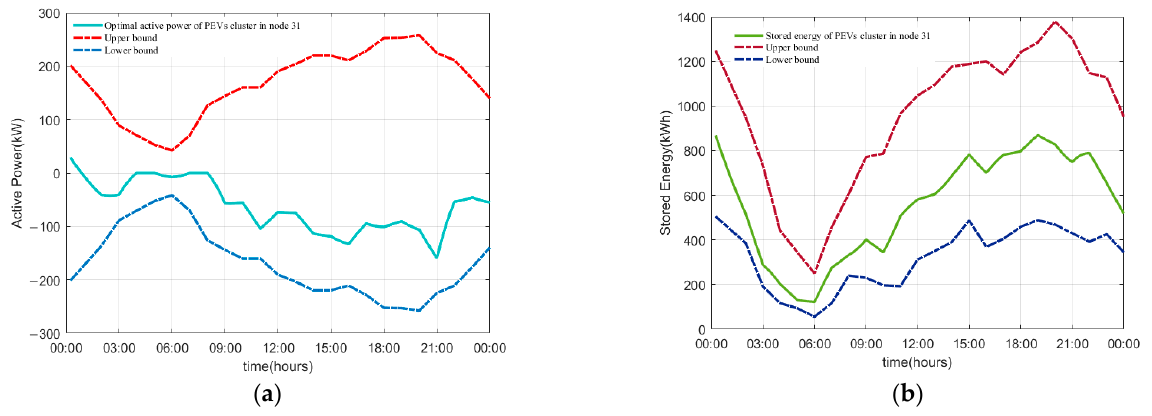
Figure 16. ( a ) Active power. ( b ) Stored energy of the cluster of PEVs in node 31 with their limits.